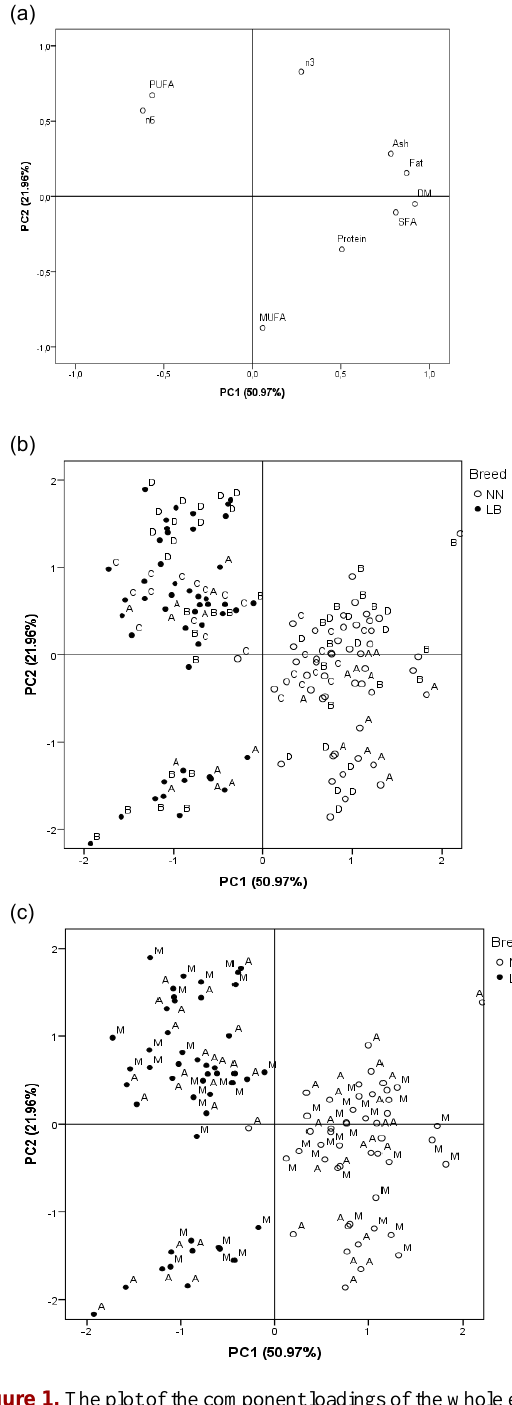
Figure 1. The plot of the component loadings of the whole eggs of three hen breeds. (a) Representation of the chemical variables as a function of both the first (PC1) and second (PC2) principal compo- nents; (b) samples grouped according to breed and age of hens vs. the first (PC1) and second (PC2) principal components; (c) samples grouped according to breed of hens and time of sampling of eggs vs. the first (PC1) and second (PC2) principal